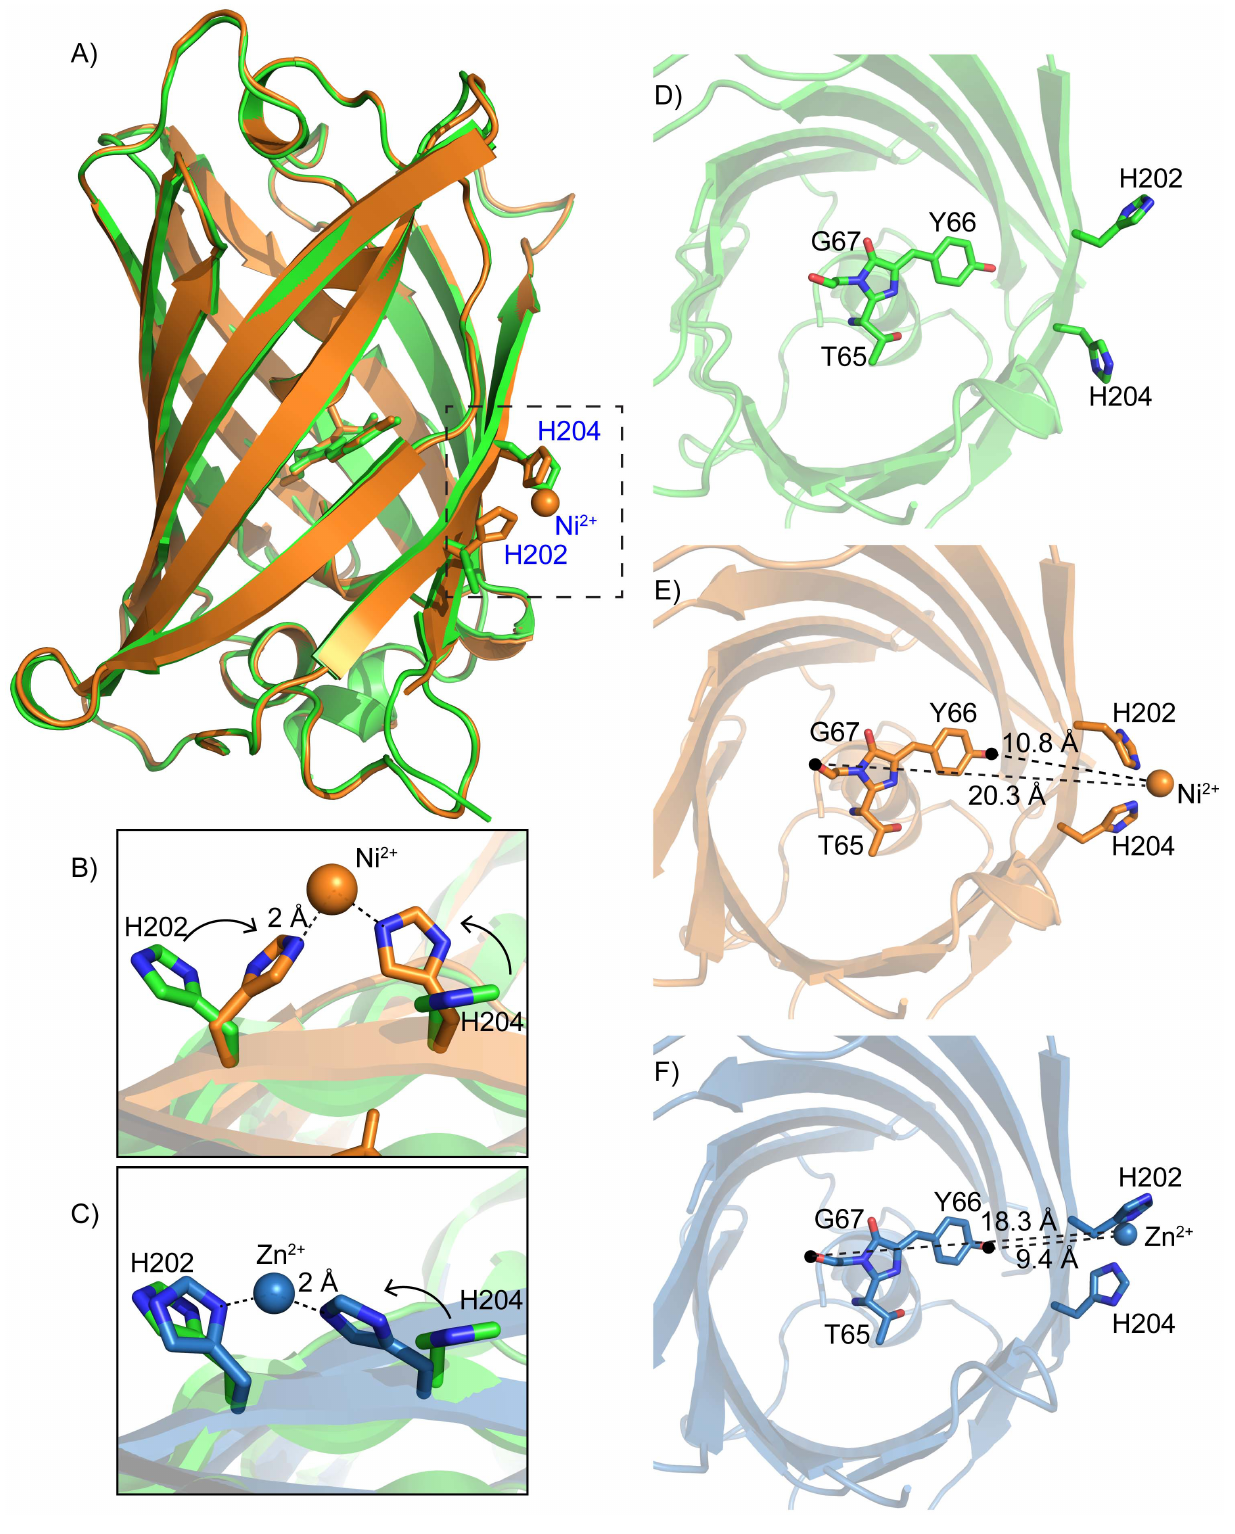
Figure 2. A) Crystal structures of an apo iq-mEmerald (green) and a nickel-bound iq-mEmerald (orange). Two histidines (H202 & H204) that are making contact with the nickel ion are indicated. B) Comparison of the metal-binding site between apo (green) and nickel-bound (orange) structures. C) Comparison of the metal-binding site between apo (green) and zinc-bound (blue) structures. D–F) Top view of iq-mEmerald (from top to bottom: apo (green), nickel-bound (orange) and zinc-bound (blue). The distance from the nickel ion to the mEmerald fluorophore is measured between 10.8 and 20.3 A˚. The corresponding distance in the zinc-bound structure is between 9.4 and 18.3 A˚.